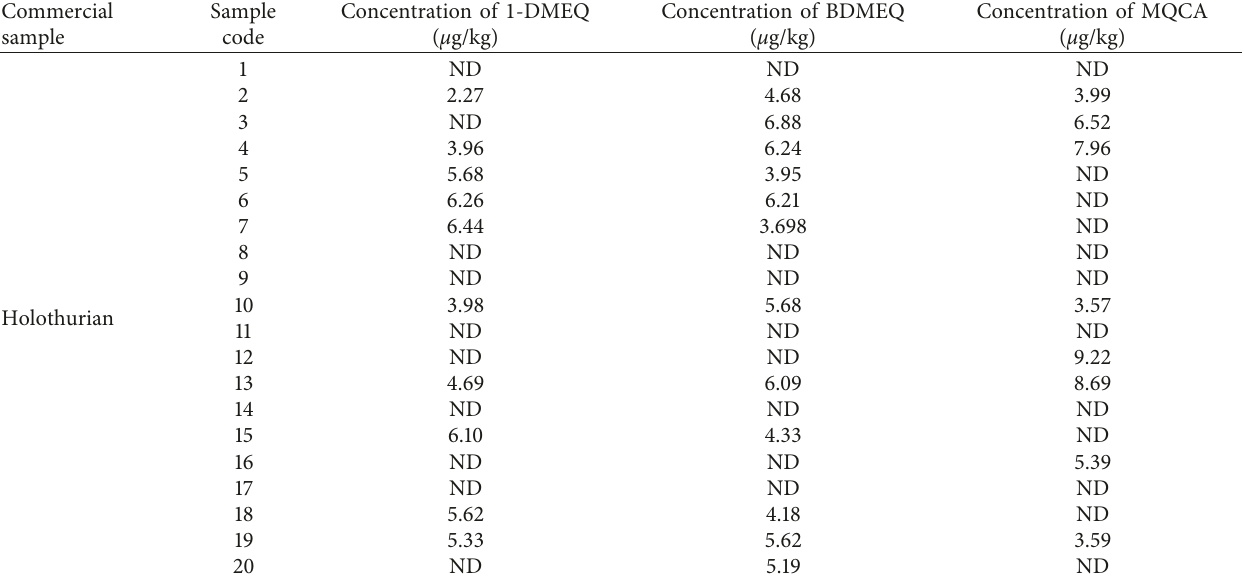
Table 5: Concentrations of 1-DMEQ, BDMEQ, and MQCA contamination in commercial holothurian samples. Commercial